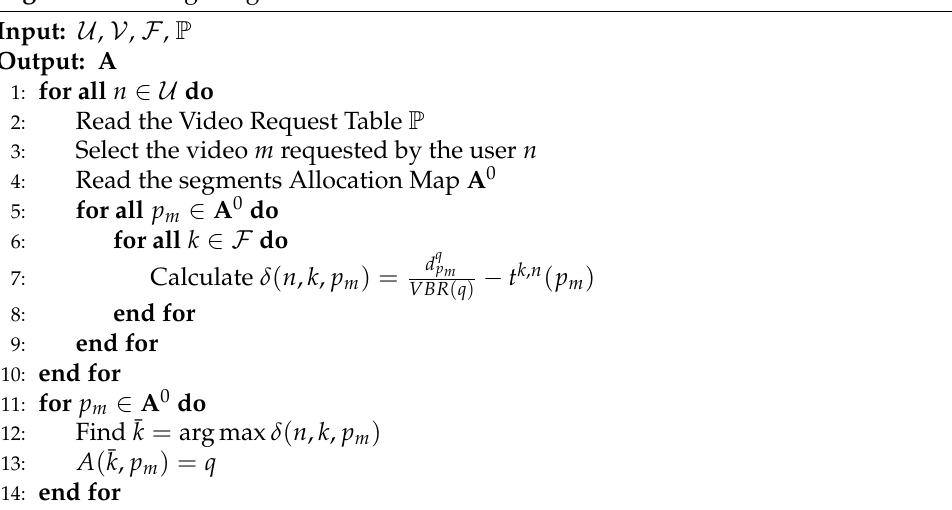
Algorithm 1 Marginal gain